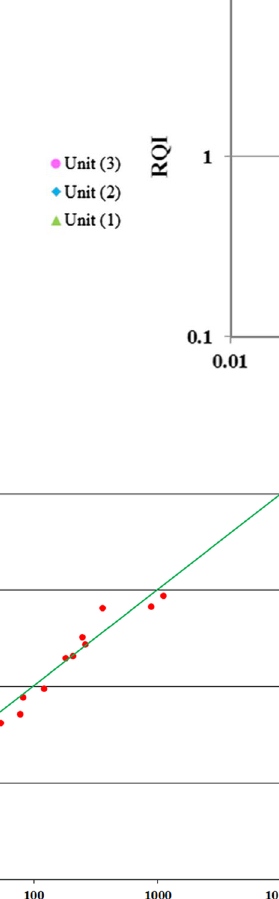
Fig. 5 ϕ Z versus RQI of the studied samples (sub-flow units)